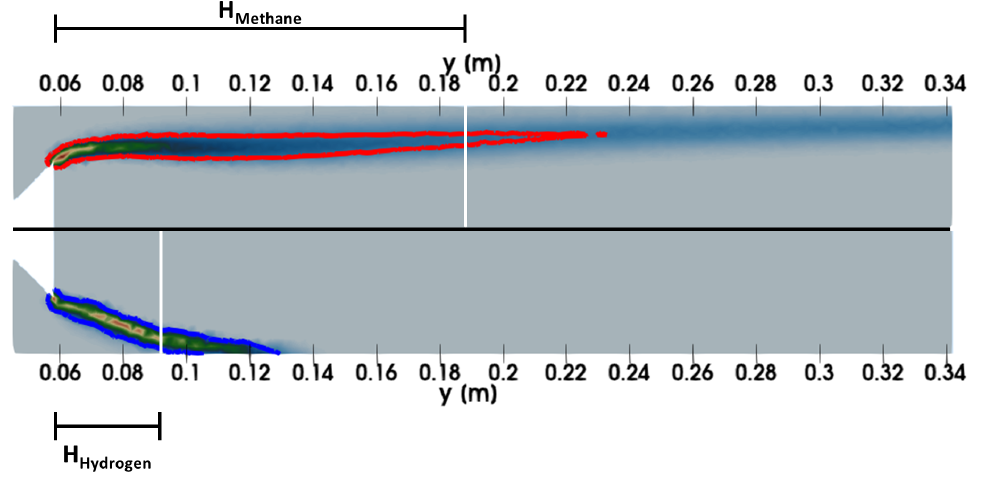
Figure 19. Schematic of the flame for the two different mixtures. The solid line denotes the flame front and H represents the length of the flame for the two